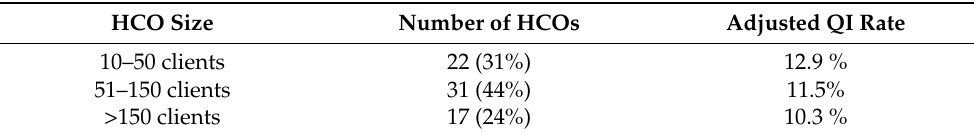
Table A1. Number of home care organizations in the study sample ( n = 70), by size.